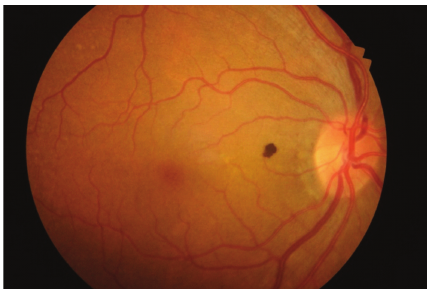
Figure 1: Heavily pigmented, small, well-circumscribed, and slight- ly elevated lesion located superonasal to the fovea and temporal to the optic disc.